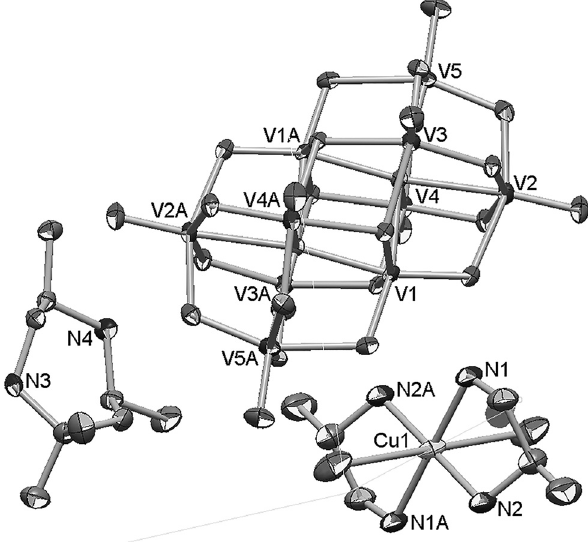
Table  : Data collection and